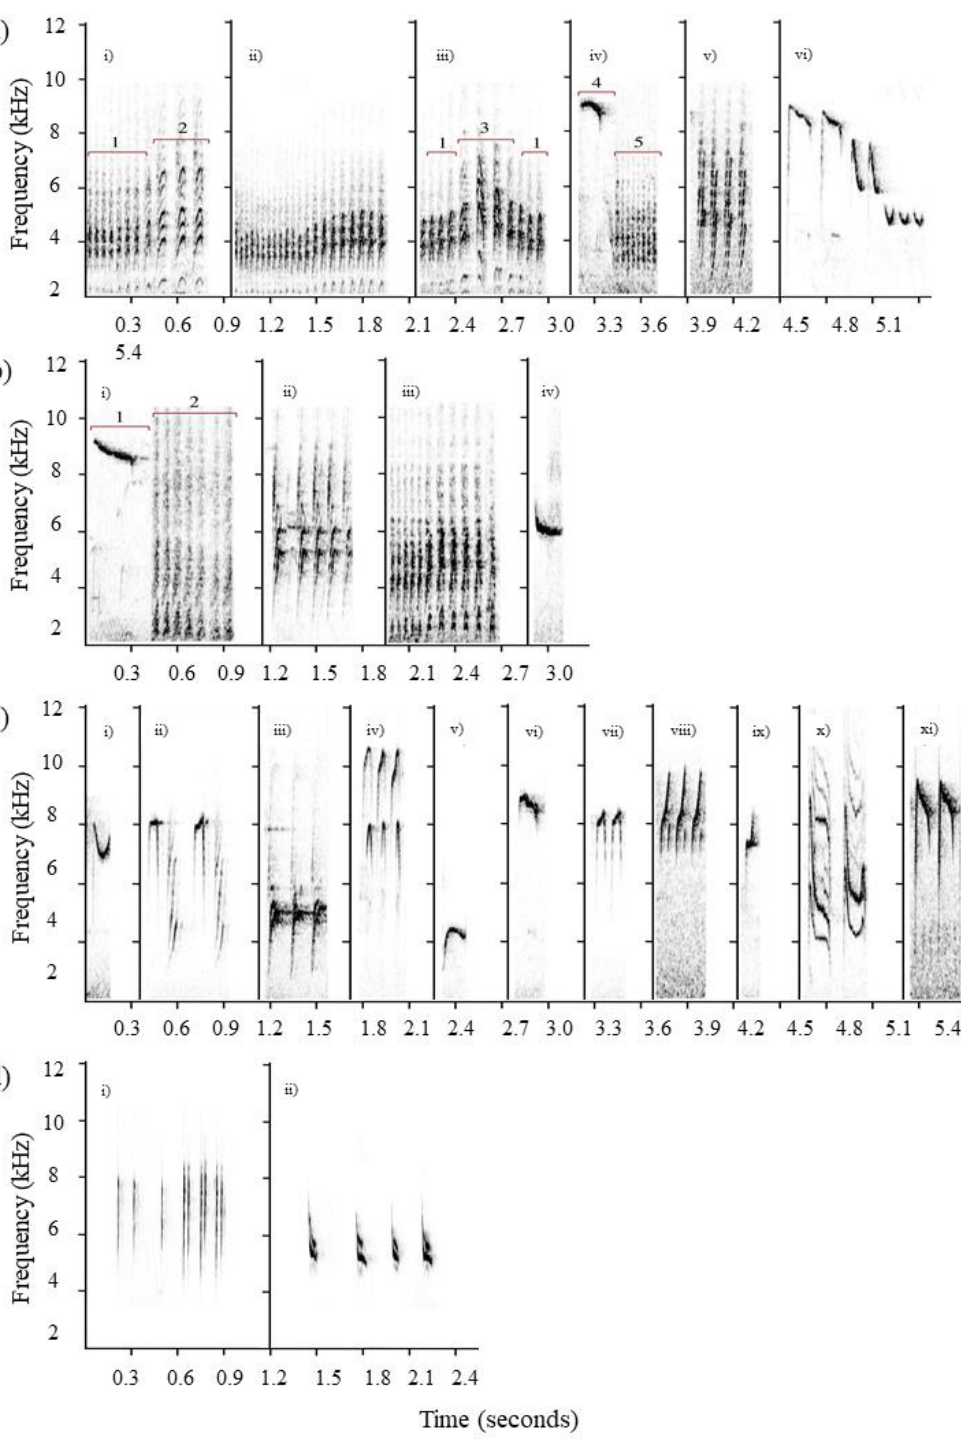
Figure 1. Compiled spectrograms of a) blue tit D (1, i, ii, iii, iv) calls with exit (2), mid (3), intro (4), short (5), and frequency- modulated (ii) elements, and chirp (v), and tonal (vi) calls; b) great tit rattle (i2) calls with intro (i1) element, chirp calls (ii), D calls (iii), and tonal call (iv); coal tit bowl (i), chirp (ii), dot (iii), hook (iv), mound (v), mt (vi), peak (vii), s-dot (viii), s (ix), squeak (x), and slide (xi) calls; d) European robin tick calls (i) and, dunnock calls